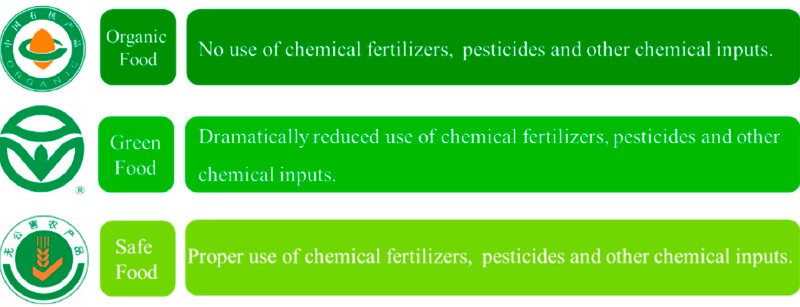
Figure 1. The three levels of food classification in China.